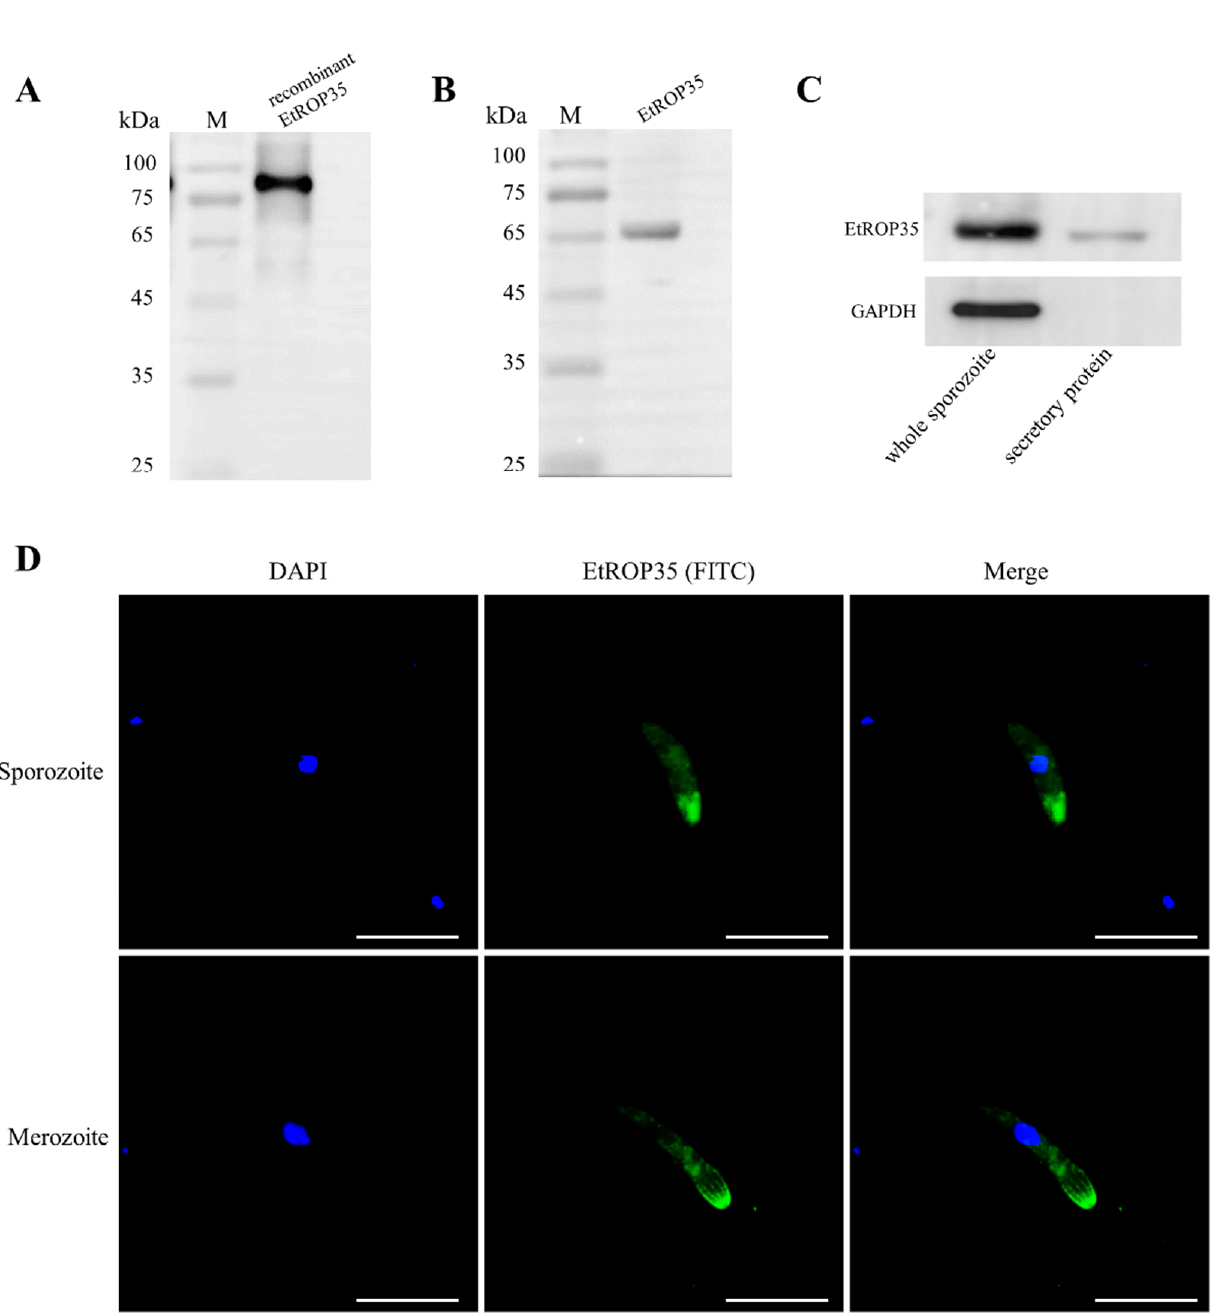
Figure 2. The Subcellular localization and secretion of EtROP35. ( A ) Evaluation of the recombinant EtROP35 by Western blot using the anti-EtROP35 polyclonal antibody (1:1000). ( B ) Investigation of the total sporozoite protein by Western blot through the anti-EtROP35 polyclonal antibody (1:1000). ( C ) Western blot analysis of the complete sporozoite protein and the supernatant (secretory protein). GAPDH is used as the reference. ( D ) Localization of EtROP35 in sporozoite and merozoite is visualized by IFA. Scale bar, 20 µ m. (Full Western Bolt is in Supplementary Materials, Figure S1A–C). 3.3. Expression of EtROP35 during Different Developmental Stages of E. tenella Results of the qRT-PCR showed that transcription level of EtROP35 was higher in the sporulated oocysts, sporozoites, and merozoites ( p < 0.01) compared to that in the unsporulated oocysts by 3.07-, 8.91-, and 10.90-fold, respectively (Figure 3A). Merozoites showed the highest transcription levels with no notable distinction from sporozoites ( p >